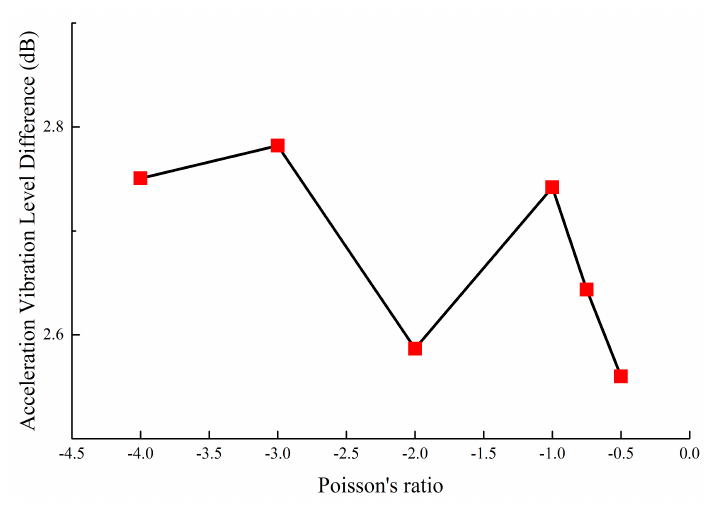
Figure 16. Vibration reduction performance of honeycomb.